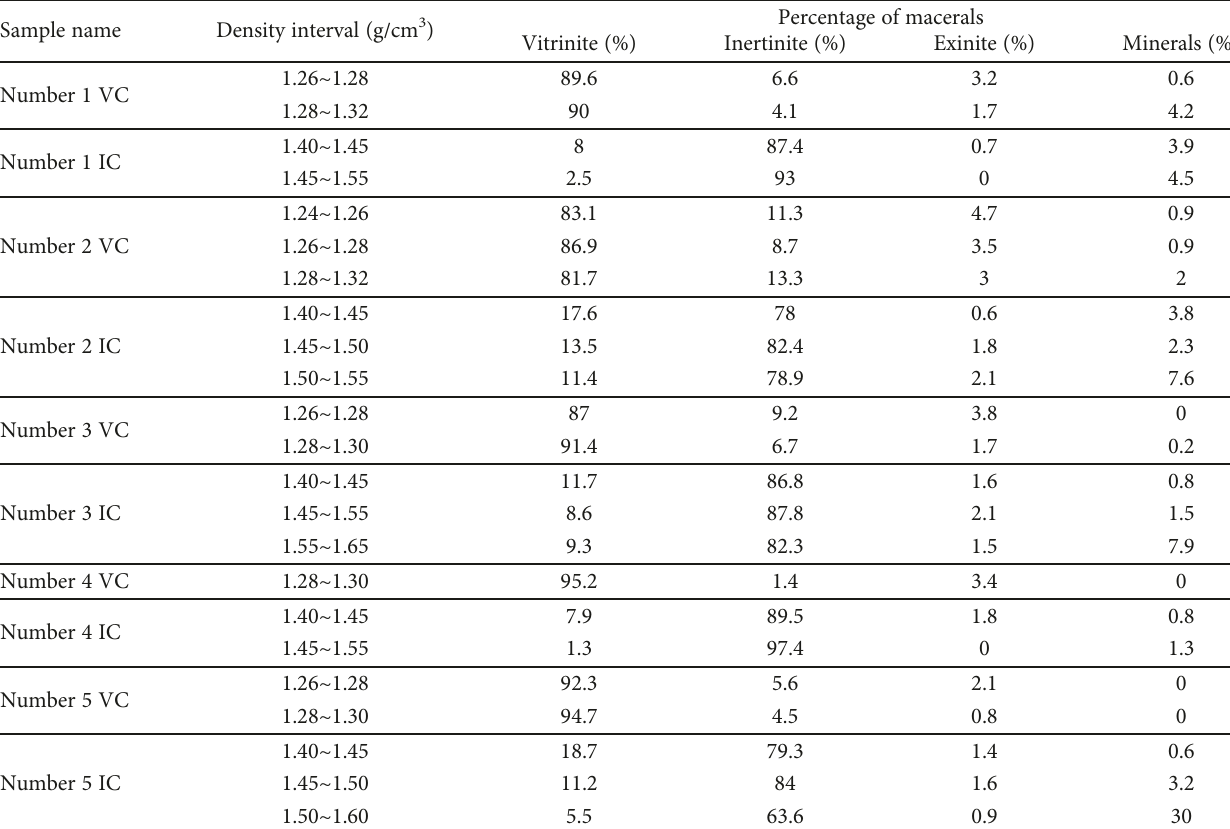
Table 5: The purity of maceral concentrates by using heavy liquid of di ff erent density